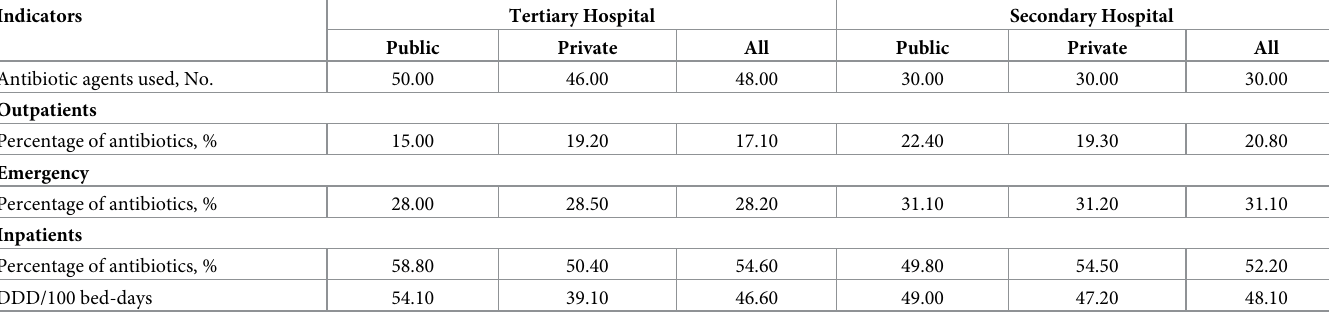
Table 5. Indicators of drug prescribing in different levels of hospitals.